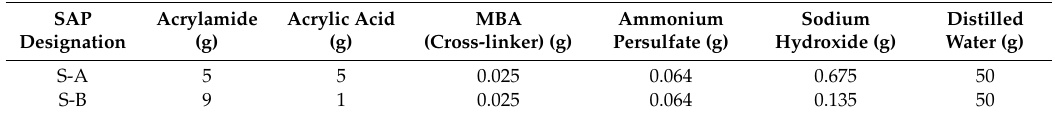
Table 1. Compositions of the superabsorbent polymer (SAP).